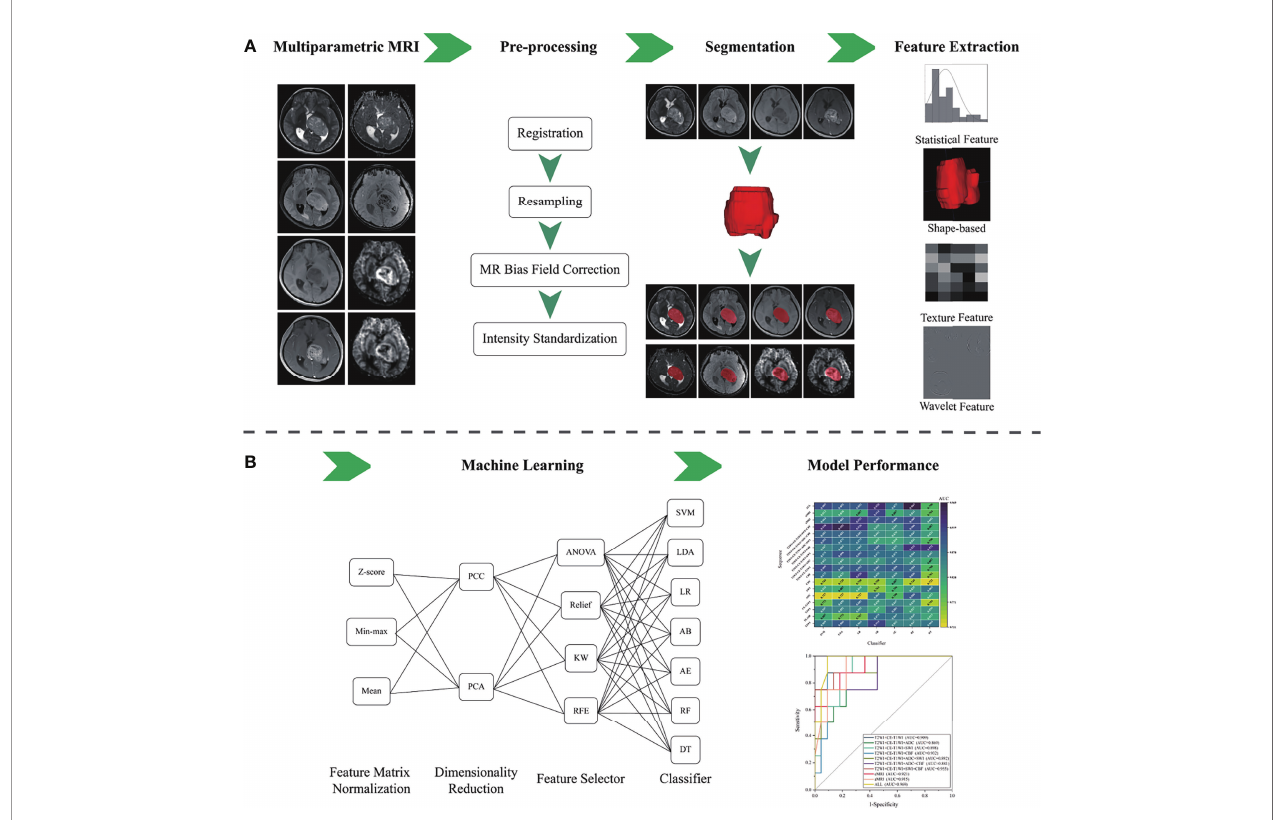
FIGURE 1 | The fl owchart of the presented study. (A) Multiparametric MRI data collection, image pre-processing, tumor segmentation, and radiomics feature extraction. (B) Machine learning and model performance